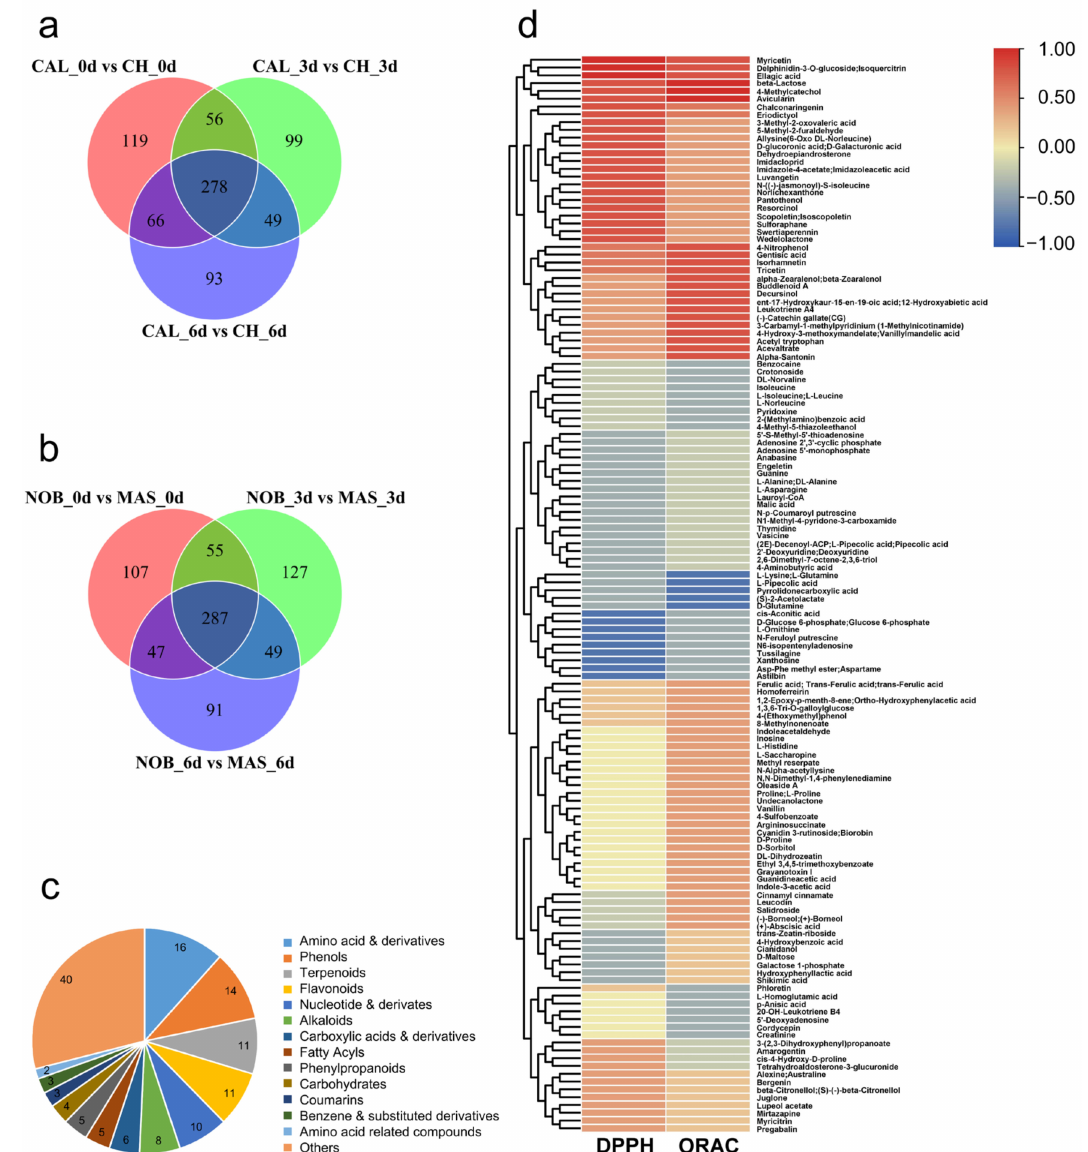
Figure 4. Selection of antioxidant-related compounds from SCMs. ( a ) Venn analysis of the SCMs in CAL vs. CH during oxidation; ( b ) Venn analysis of the SCMs in NOB vs. MAS during oxidation; ( c ) classification of the core 138 SCMs between CAL vs. CH and NOB vs. MAS; ( d ) and correlation heat map of core the 138 SCMs and antioxidant